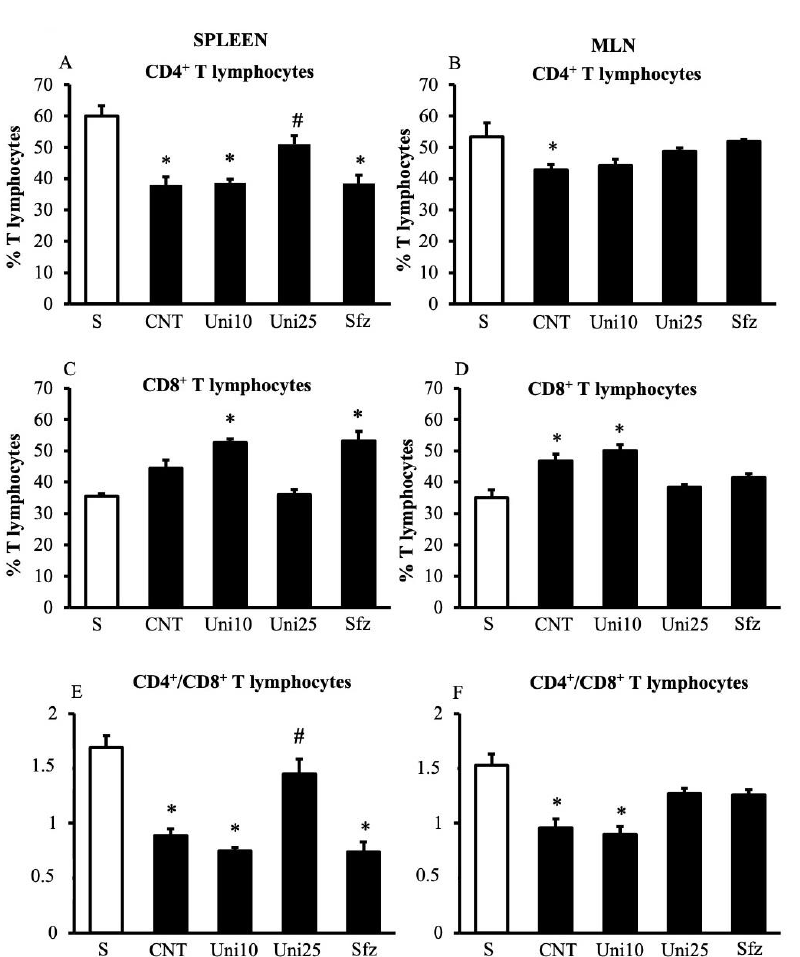
Figure 4. UniPR1331 mitigated TNBS-induced changes in spleen T cells profile. Percentages of CD4+ ( A , B ), CD8+ ( C , D ), and the ratio between CD4+ and CD8+ T lymphocytes ( E , F ) were assessed in the spleen ( A , C , E ) and MLN ( B , D , F ) excised from vehicle-treated normal mice (S) and TNBS-treated mice administered with vehicle (CNT), UniPR1331 10 mg/kg (Uni10) or 25 mg/kg (Uni25), or sulfasalazine 50 mg/kg (Sfz) ( n = 5–15 independent values per group). * p < 0.05 vs. S mice; # p < 0.05 vs. CNT mice, one-way ANOVA followed by Bonferroni’s post-test. 2.3. Treatment with UniPR1331 Did Not Influence Colonic Eph/ephrin Gene Expression As regards colonic Eph/ephrin gene expression, TNBS application did not change the levels of mRNA transcripts of EphA2 and ephrin-A1, since single bands of similar inten- sity were detected in colonic tissues of S and CNT mice; neither the treatment with UniPR1331 at 25 mg/kg nor that with the recombinant protein EphA2 affected EphA2 or ephrin-A1 gene transcription (Figure 5).